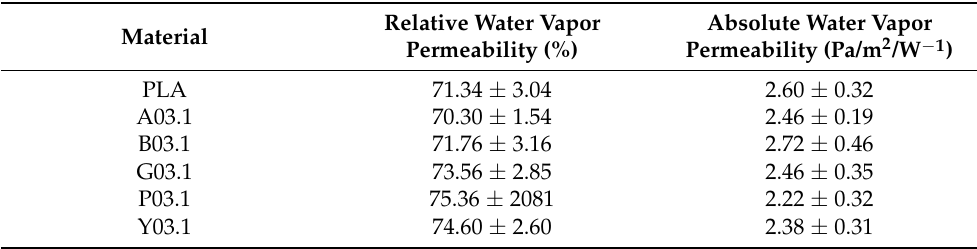
Table 6. Relative and absolute water vapor permeability of knitted fabrics made from PLA and dyed PLA yarns containing 0.3% ( w / w ) of colorants. Data are means ± SD ( n = 5).